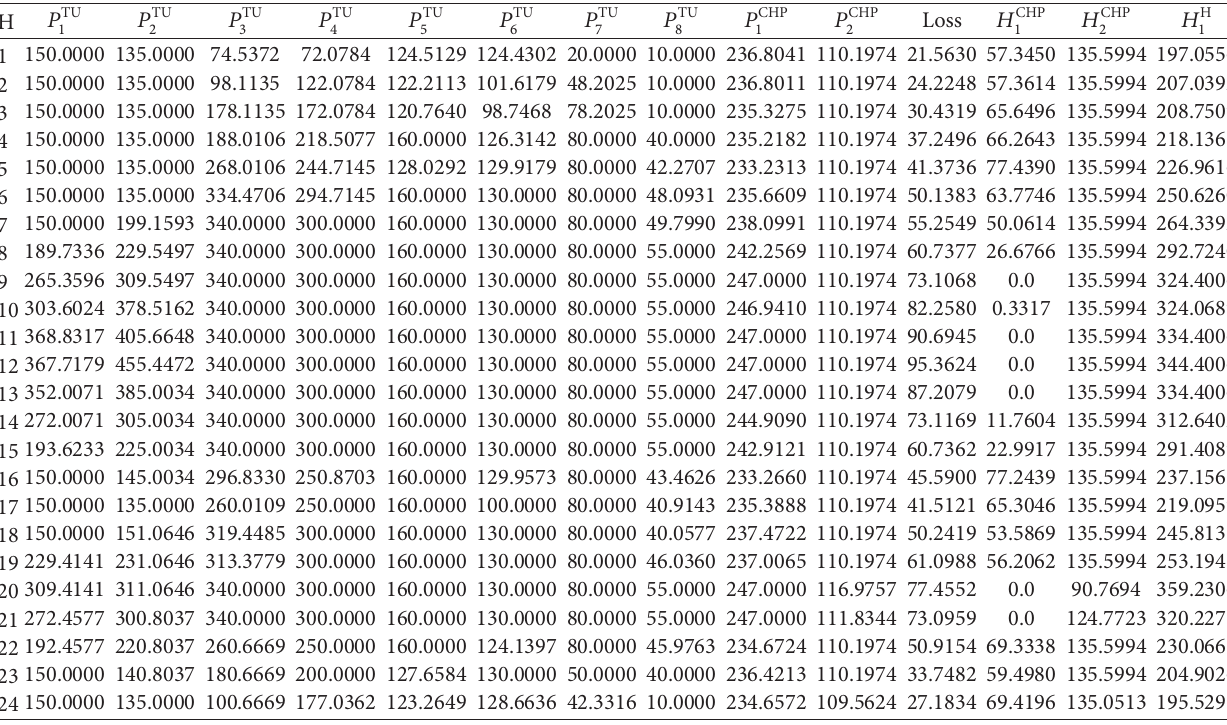
Table 5: Hourly heat and power schedule obtained from CHPDED.